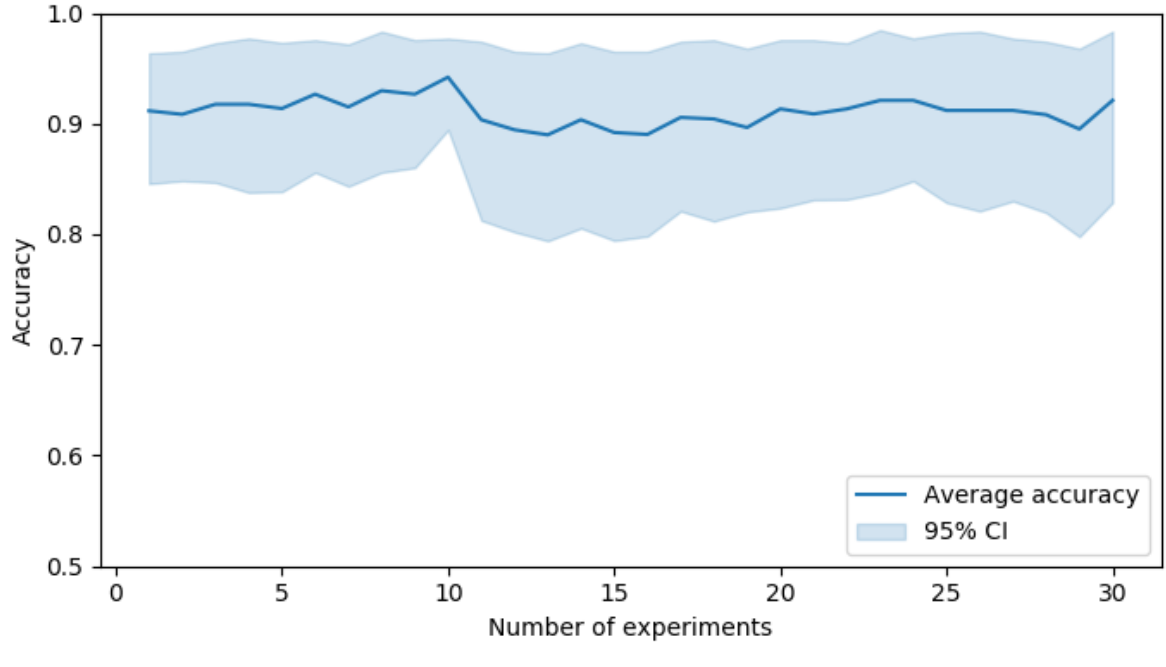
Figure 6. Average participant accuracy, according to the number of completed hand hygiene